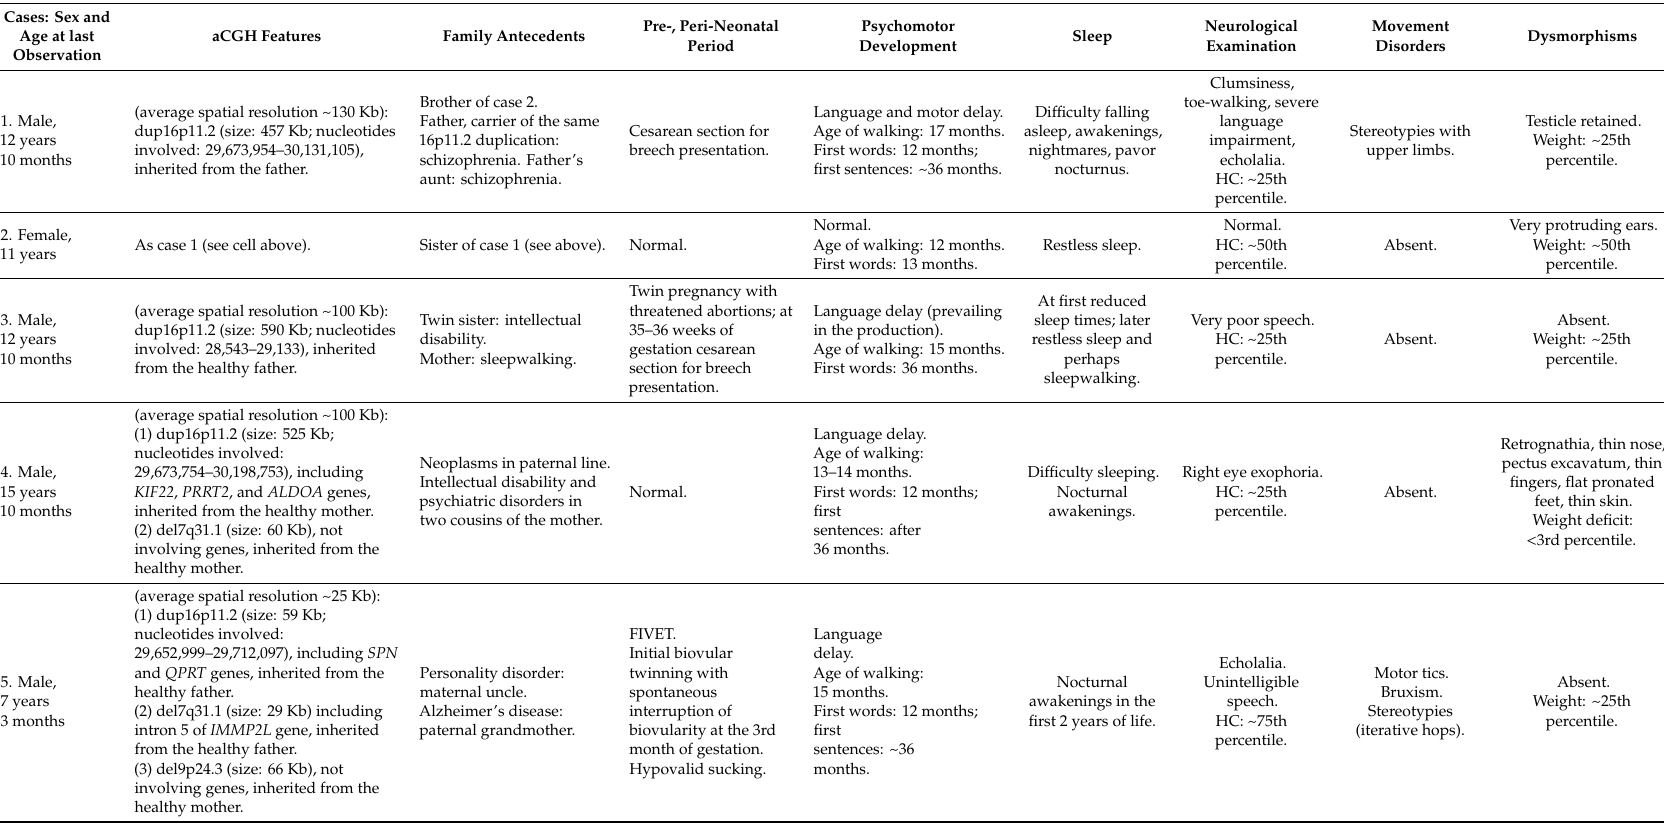
Table 1. Genetic and clinical features of five cases with